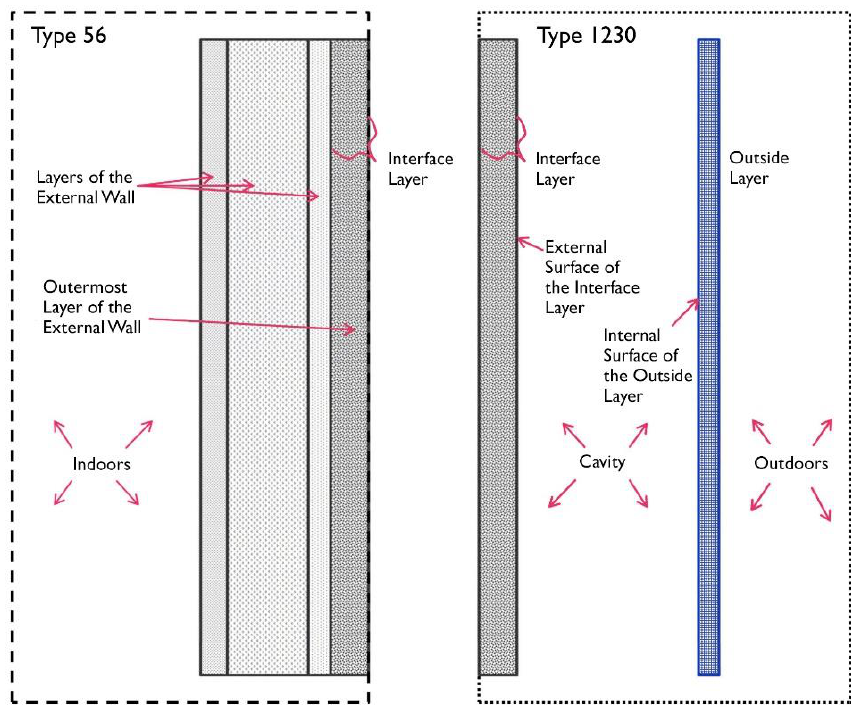
Figure 9. Coupling between Type 56 and Type 1230 [61].